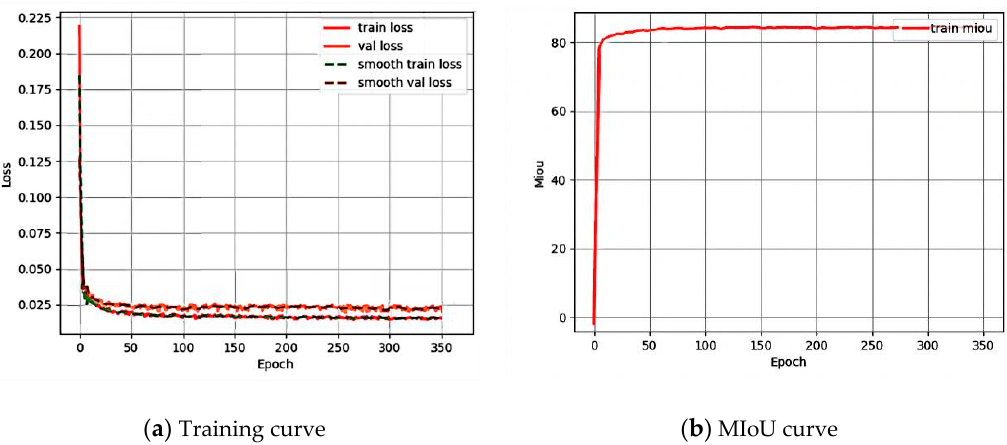
Figure 14. Training curve and MIoU curve of MobileNetv2-PSPNet model.